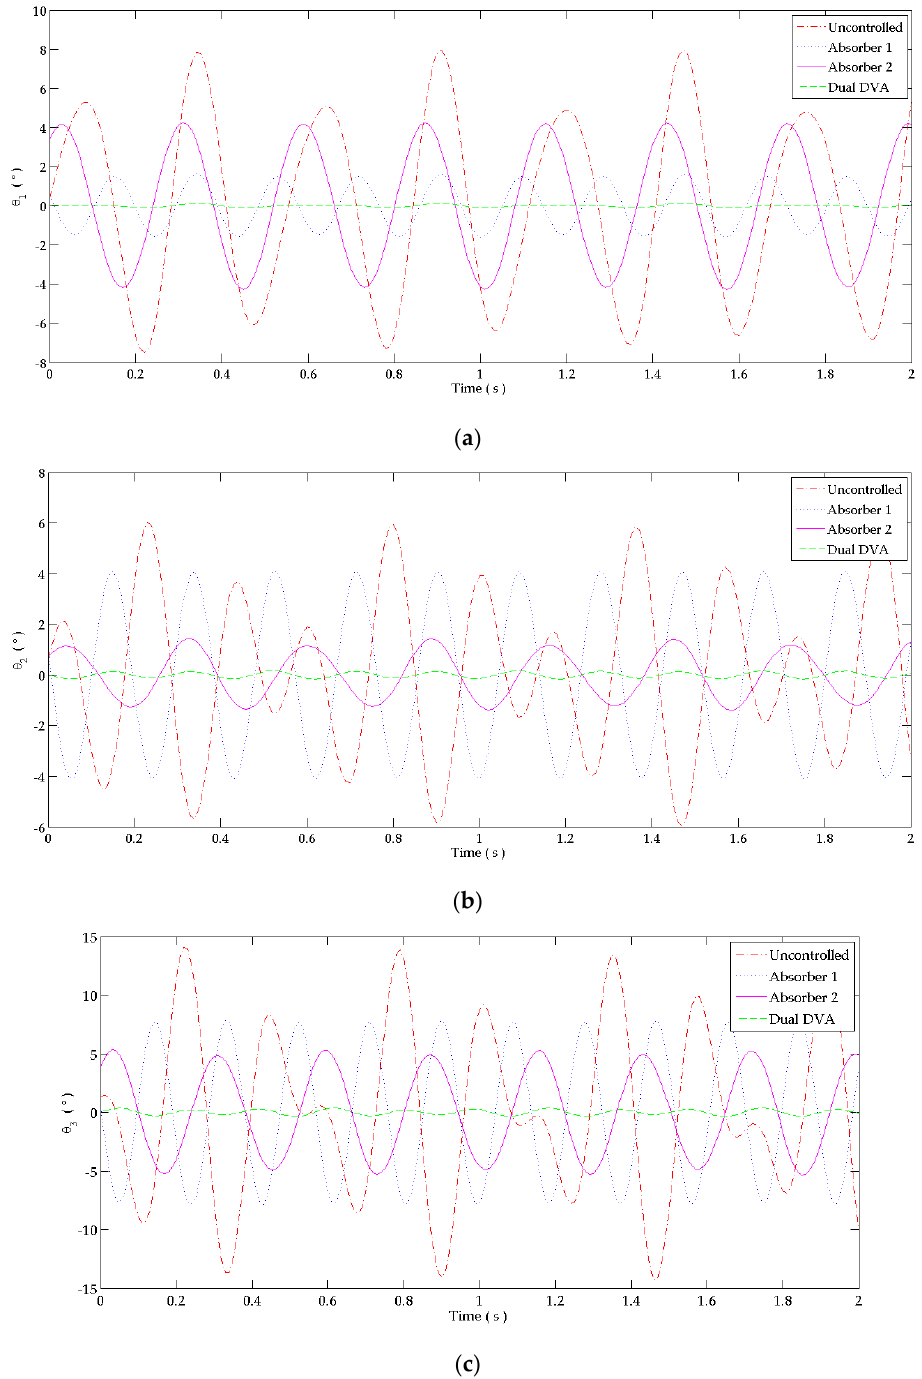
Figure 8. Response in the time domain at: ( a ) Shoulder joint; ( b ) Elbow joint; ( c ) Wrist joint. The behavior at each joint is studied when attaching to the forearm: “absorber 1” alone, “absorber 2” alone and the “dual DVA” tuned at wrist joint’s responses. It is compared to the response of the uncontrolled system.